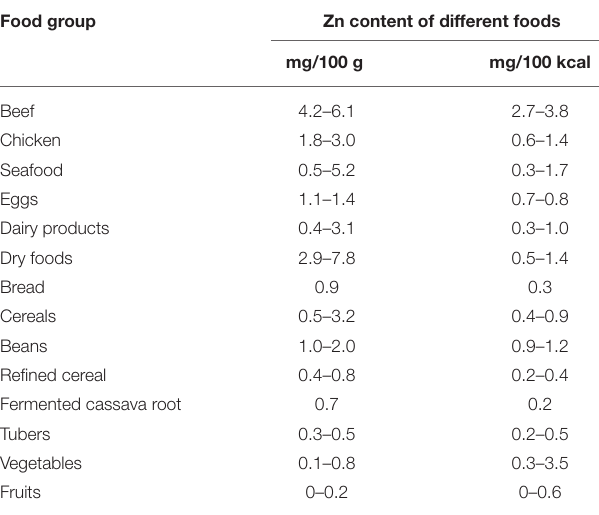
TABLE 2 | Zn rich foods with Zn